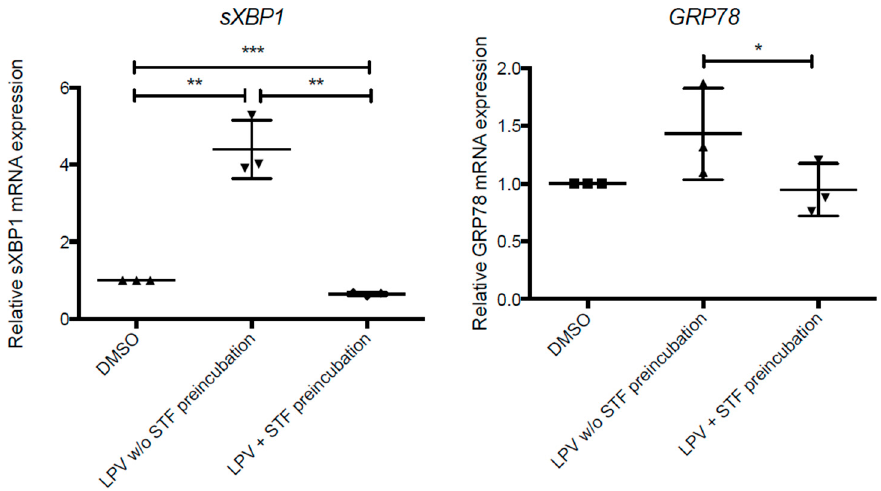
Figure 13. Inhibition of IRE1 α pathway partially prevents the UPR pathway activation .